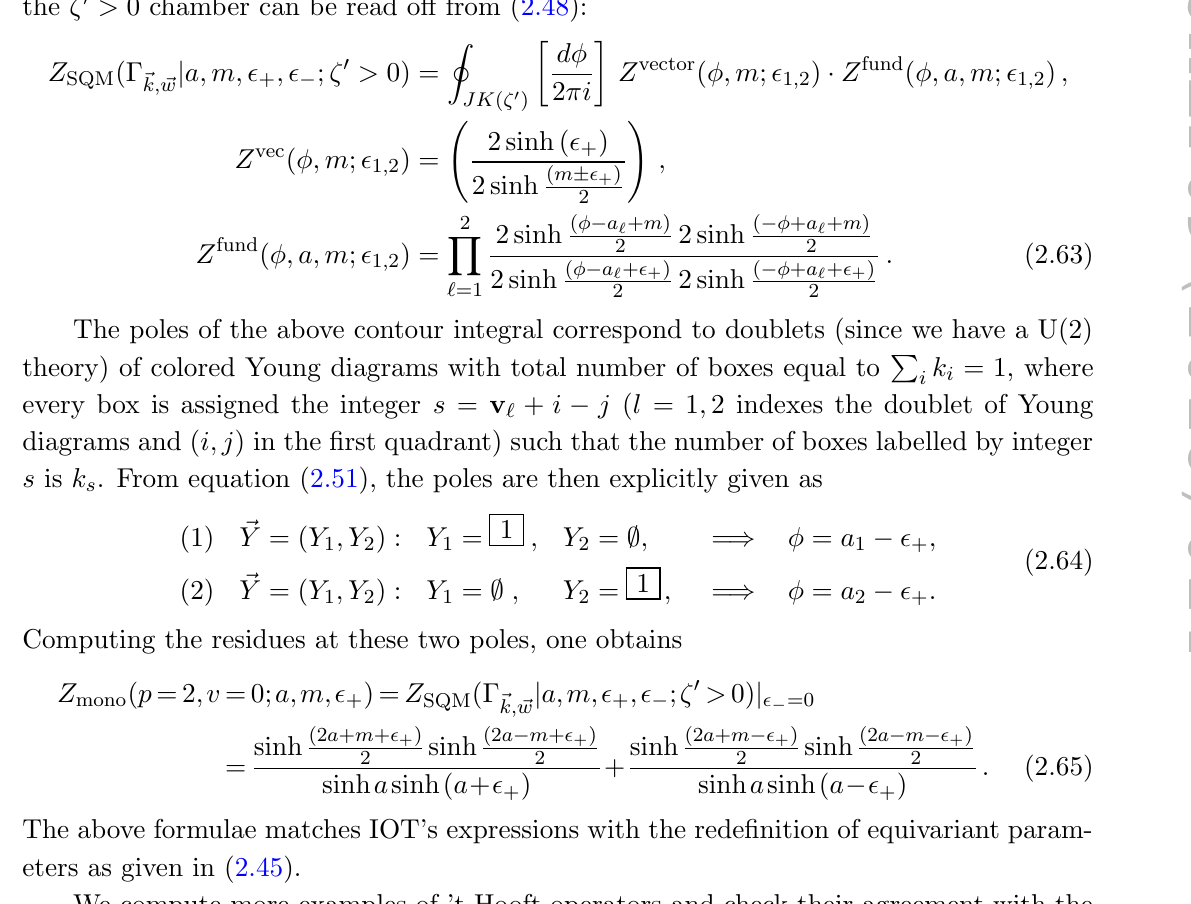
Figure 5 . The Kronheimer-Nakajima quiver associated to a ’t Hooft loop labelled by B = 1 in the sector v = (0 ; 0) in an N = 2 (cid:3) SU(2) theory. This corresponds to the integer p = 2 in the (cid:12)gure